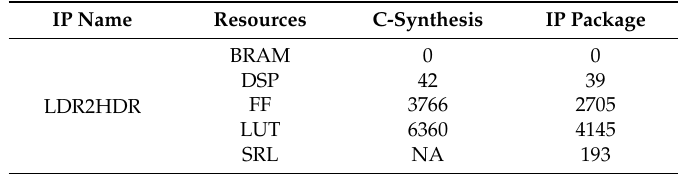
Table 5. Resource comparison between C-synthesis and IP packaging stage.